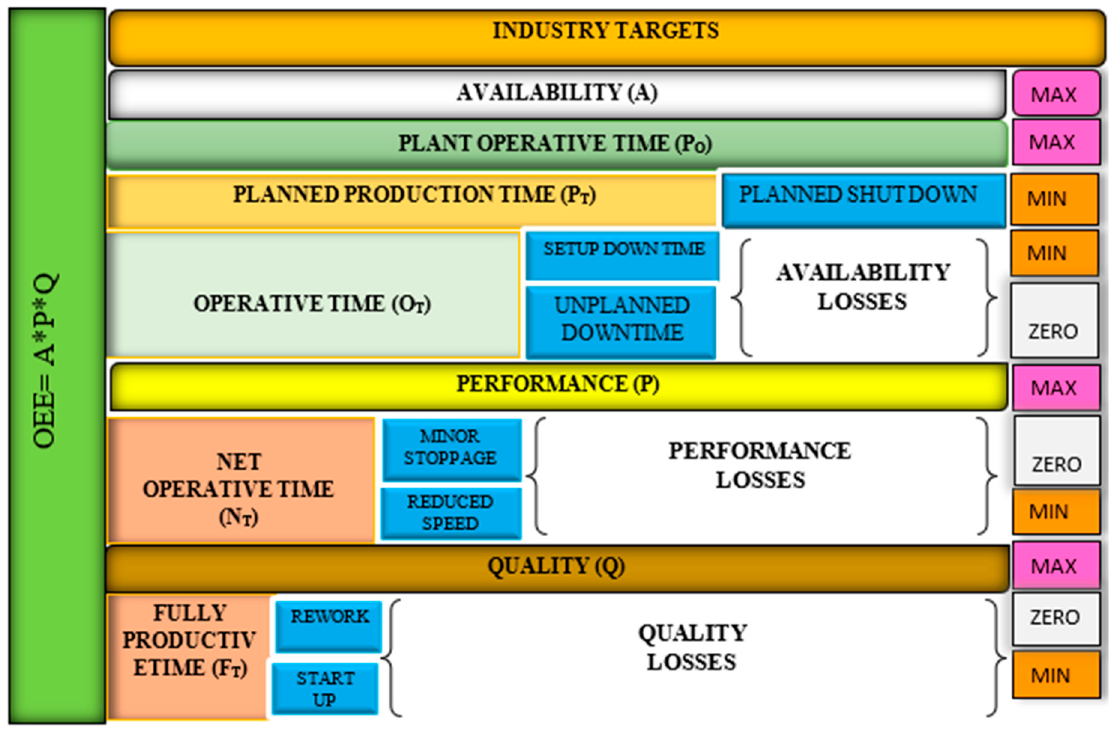
Figure 2. Overall equipment effectiveness (OEE) model.